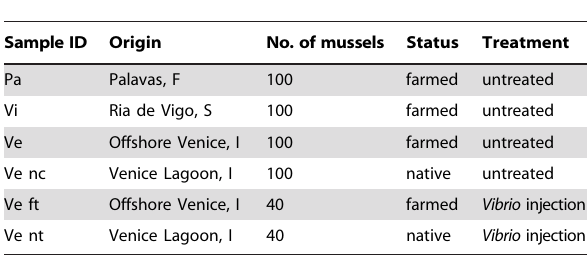
Table 2. Description of the mussel haemolymph samples processed for 454